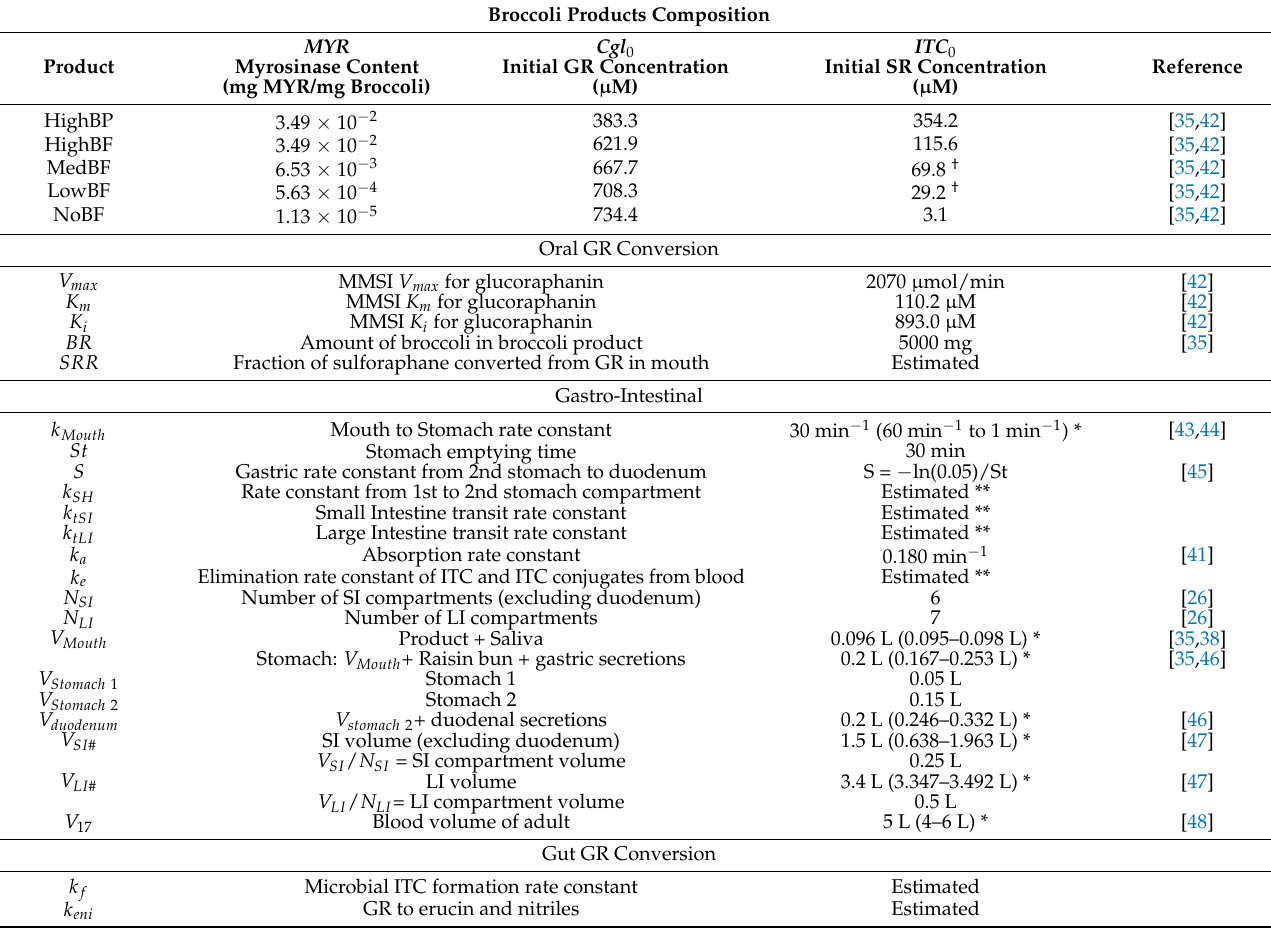
* Ranges for the parameters were determined based on literature. ** These values were estimated for each individual participant based on the model fit of the experimental values. † ITC 0 values used in final fittings for MedBF and LowBF were approximately 3.4 and 9.1%, respectively, of their values in this table due to poor fit results using the original